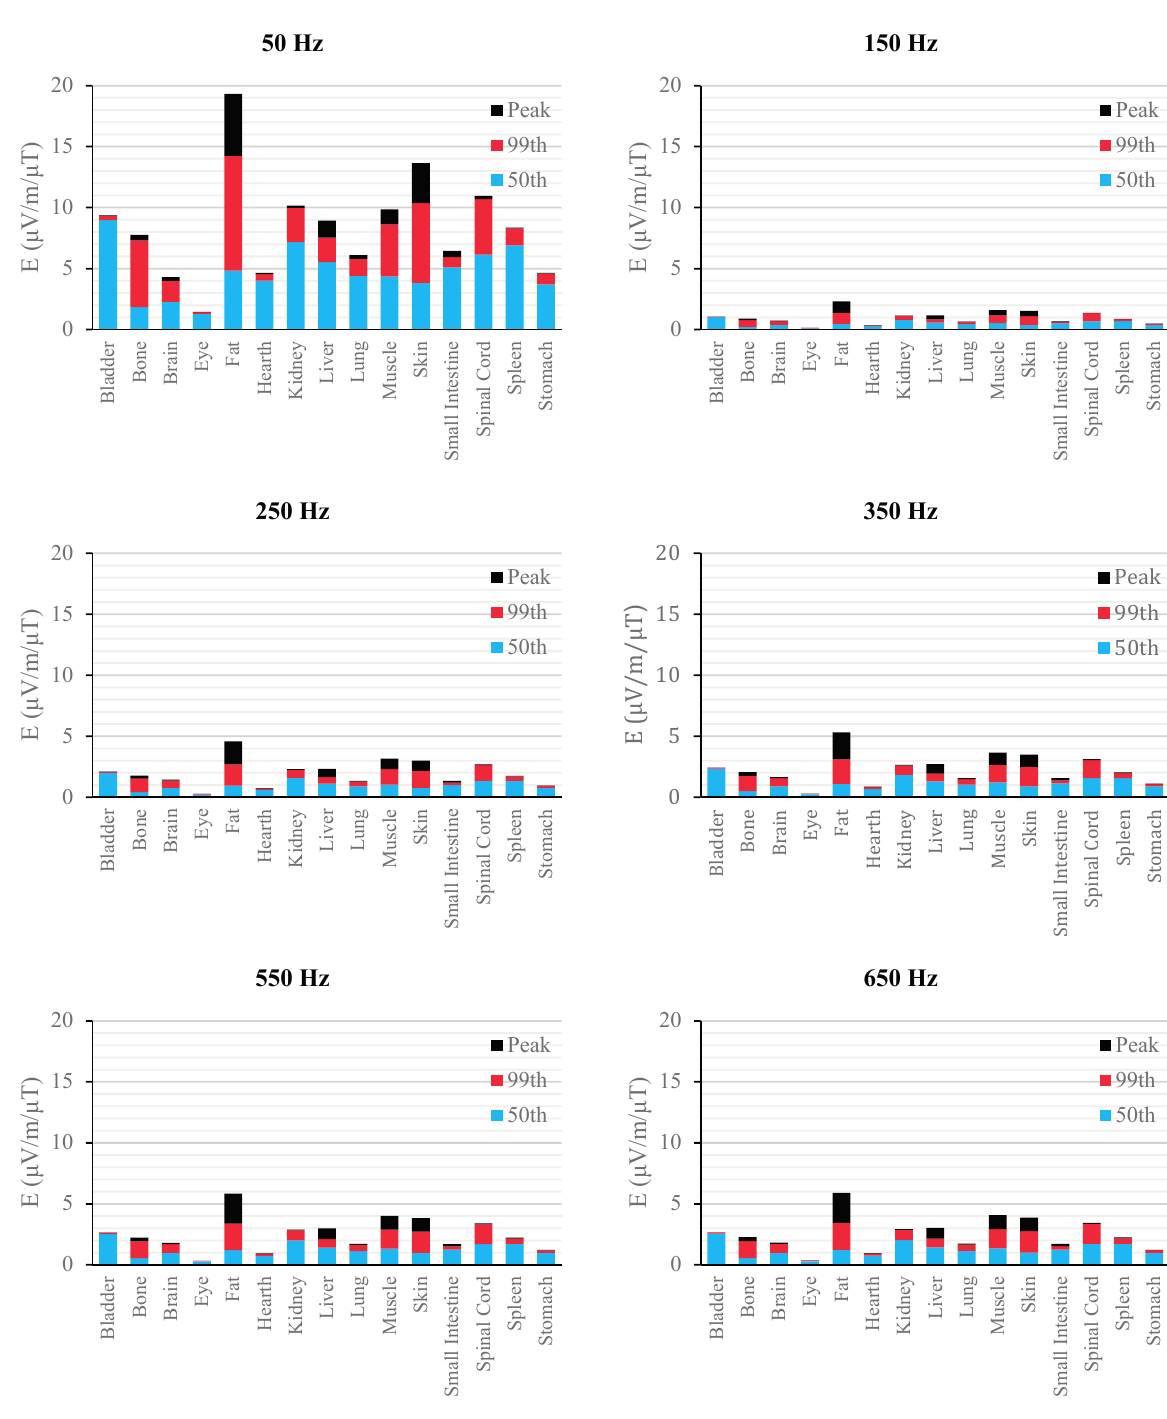
Figure 2. E ( μ V/m) per μ T of 50 Hz B peak induced in foetal tissues at 3 mGA for all the harmonic frequencies considering the standard EN 50160 for the LV&MV power supply networks. The bars indicate the E 50th (blue), the E 99th (red) percentiles and the E peak (black) of each